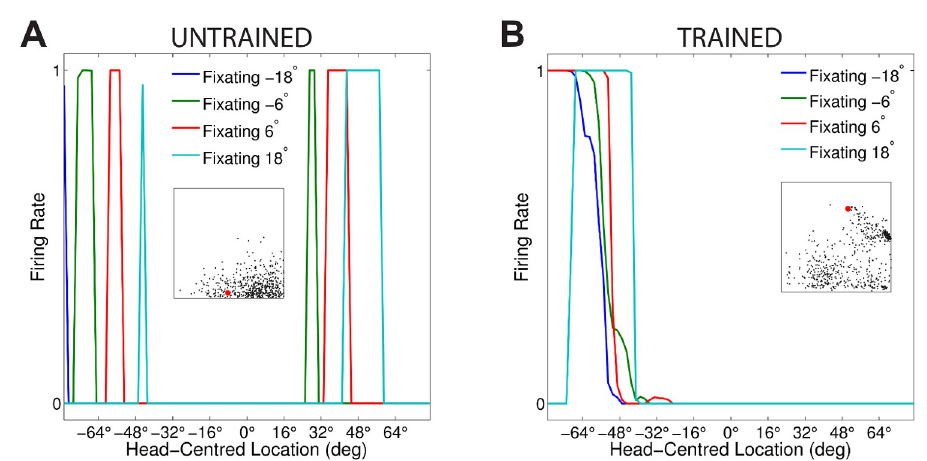
Fig 12. Simulation results showing the firing rate responses of a model incorporating a population of monotonic modulated input neurons trained with the modified learning rule 16: Delayed postsynaptic trace with anti- Hebbian learning. The figure shows the firing rate responses of output neuron #168 before training (A) and after training (B) during testing for four different eye-positions: − 18˚, − 6˚, 6˚ and 18˚. In each subplot, each curve corresponds to a fixed eye-position while a visual target is presented across the same range of head-centred locations. The miniature scatter plot shows the reference frame values of all neurons in the output layer, where each neuron is plotted as a point corresponding to that neuron’s particular combination of head-centredness (ordinate) and eye- centredness (abscissa). The neuron whose firing rate responses have been plotted is shown in the scatter plot by a red mark. After training it is evident that this neuron responds reasonably invariantly to a visual target presented at the same head-centred location regardless of the eye-position.